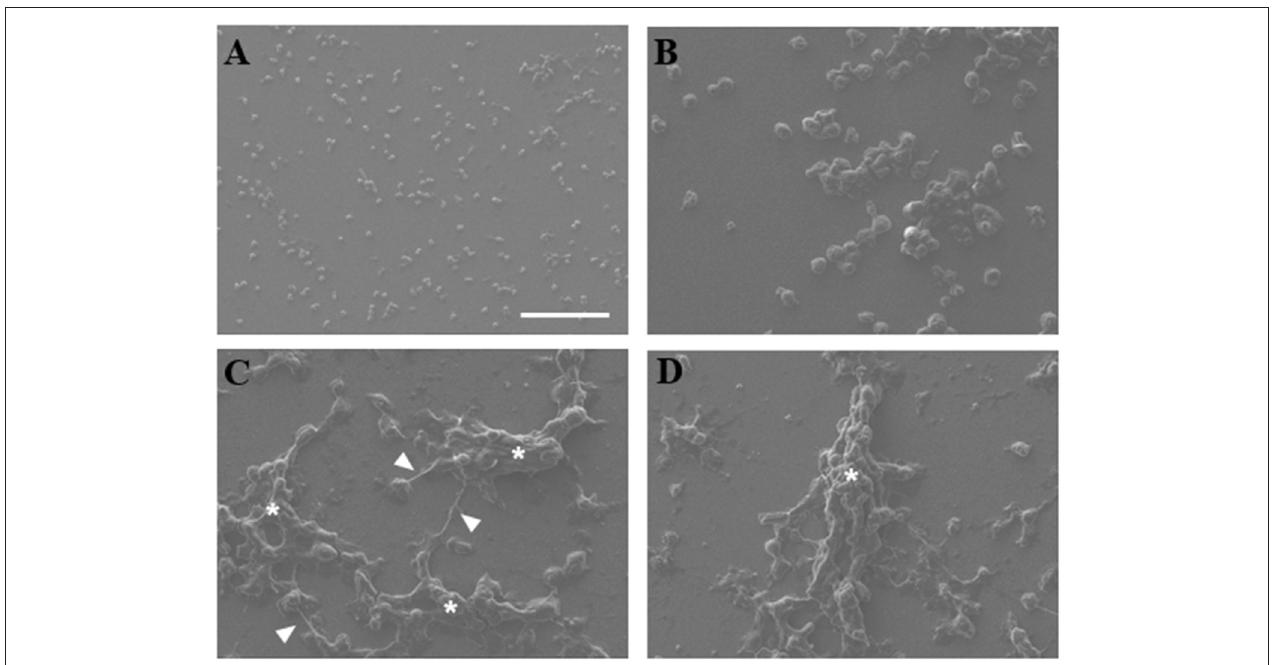
FIGURE 2 | Scanning electron microscopy of NETs induced by amoebas. (A) Neutrophils, (B) trophozoites, or (C,D) co-cultured neutrophils-amoebas (ratio 20:1) were incubated during 4h at 37 ◦ C. Posteriorly, cells were fixed, dehydrated, air dried, and coated with gold. Fibrillar structures (arrowhead) and clusters of amoebas trapped in the fibrillar material (asterisks) are shown. Images were taken at 250x magnification. Scale bar 100 µ m.